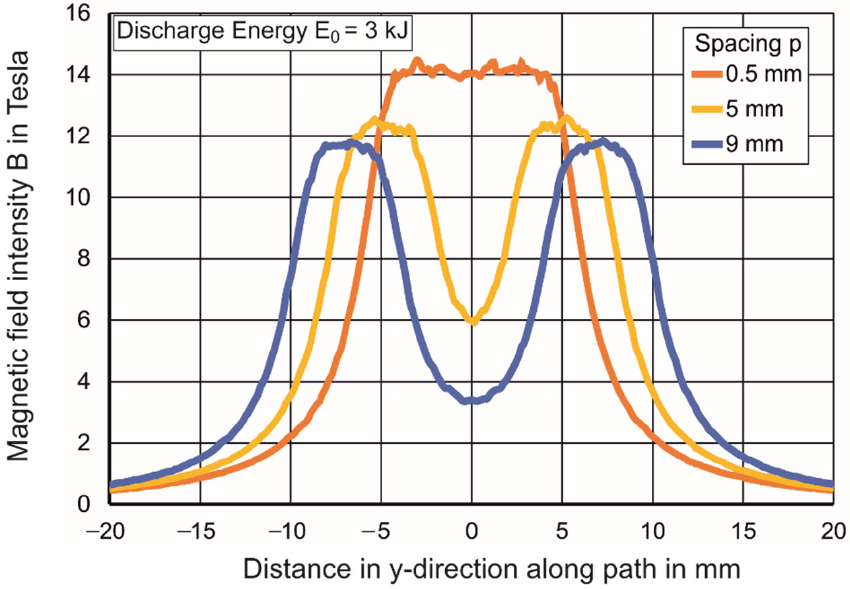
Figure 16. Numerically determined magnetic field intensity along path 2.